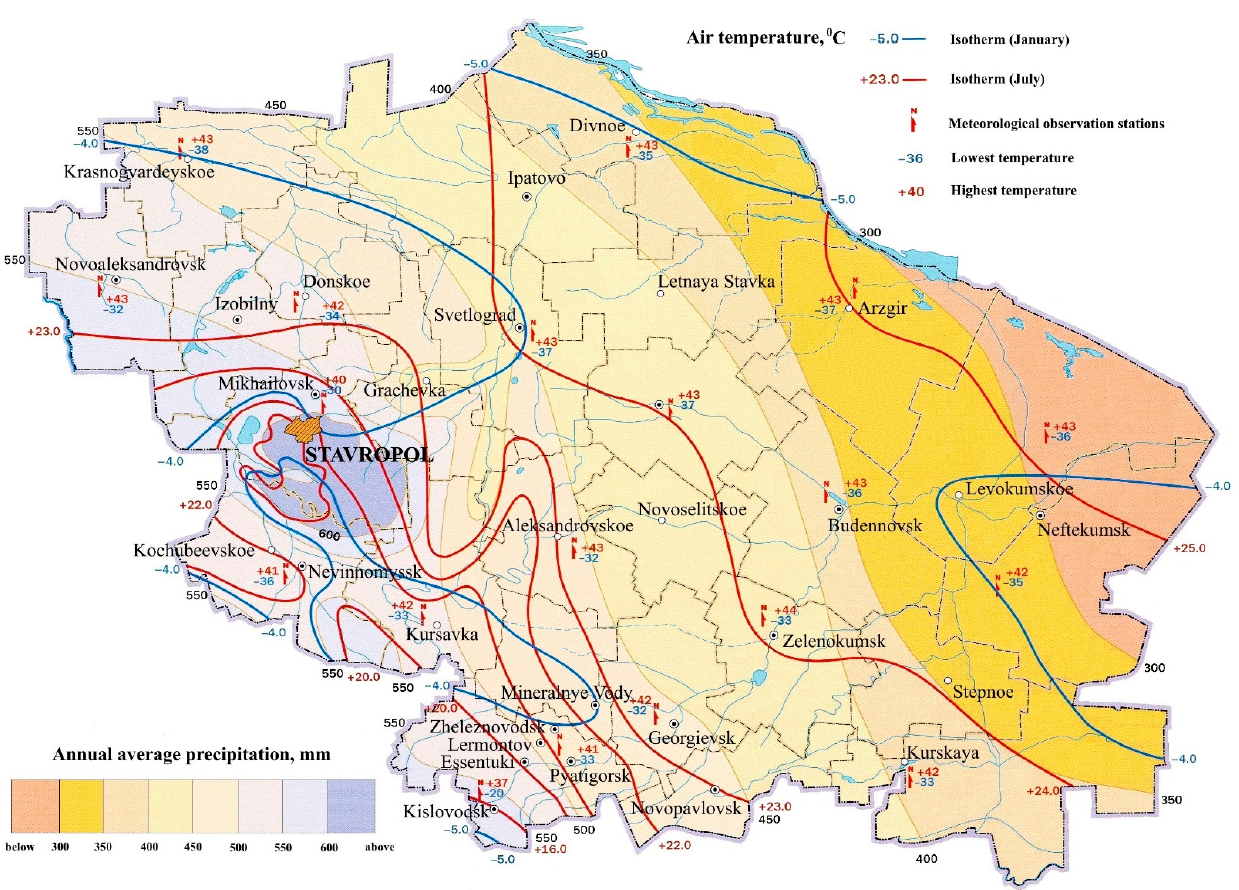
Figure A1. Stavropol Krai: Climate parameters. Source: authors’ development.